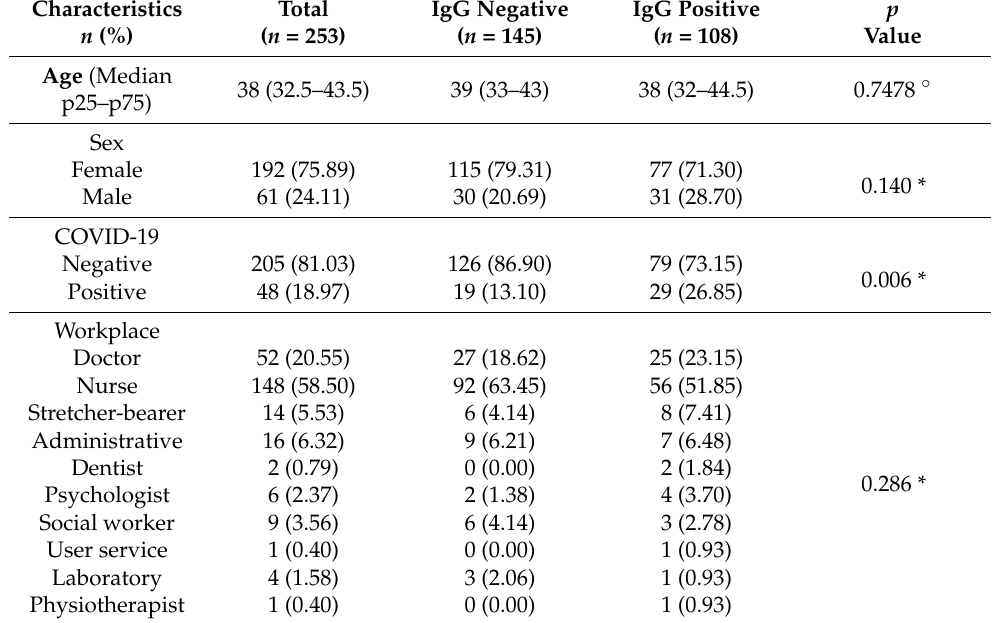
Table 1. IgG seroprevalence in the studied